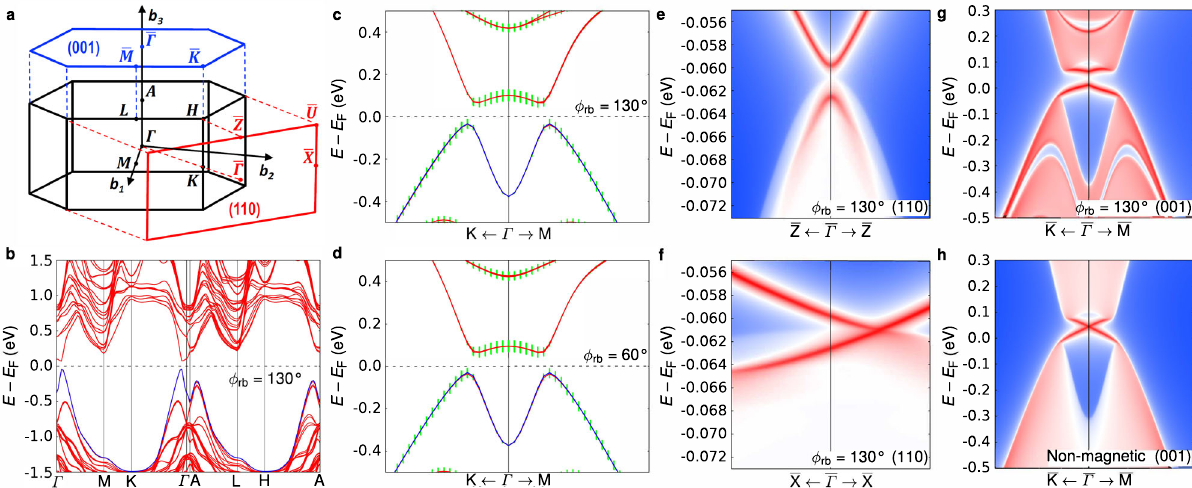
Fig. 3 Bulk and surface electronic-band structures for various magnetic ground states. a Hexagonal Brillouin zone and the projected (110) and (001) surface-Brillouin zones with high-symmetry points (capital letters) and reciprocal-lattice axes ( b 1 = a * , b 2 = b * , and b 3 = c * ) indicated. b Bulk band structure along high-symmetry paths for broken-helix order with ϕ rb = 130 ∘ . E F is the Fermi energy. c , d Views of the minimal gap region along the K- Γ -M direction for ϕ rb = 130 ∘ (broken-helix order) ( c ) and ϕ rb = 60 ∘ (pure 60 ∘ -helix order) ( d ) . The top valence band according to simple band fi lling is indicated in blue and the rest of the bands are colored red. Green vertical bars show As 4 p z orbital character and indicate band inversion near the minimal gap. e – h Surface bands for the (110) ( e , f ) and (001) ( g , h ) projected surfaces along high-symmetry lines for ϕ rb = 130 ∘ ( e – g ). A Dirac cone exists on each surface, but the presence of a gap and whether or not the cone is pinned to a time-reversal-invariant momentum (TRIM) depends on symmetry: a gapless Dirac cone unpinned from a TRIM occurs for the (110) surface preserving the 2 0 symmetry axis. On the other hand, the (001) surface ( g ) has a gapped Dirac cone at (cid:1) Γ due to the absence of a 2 0 axis and any other symmetry that reverses an odd number of space – time coordinates. The surfaces with gapped Dirac cones support half-integer quantum-anomalous-Hall-type conductivity. The non-magnetic calculation for the (001) surface ( h ) has a gapless Dirac cone pinned to (cid:1) Γ . Note that panels e and f are zoomed in around the bottom of the band gap to show the details of the surface Dirac cone. E F is inside the gap and the surface Dirac point is at E F − 0.061 eV, very close to the top of the valence band projection. More details of the surface band structure are found in Supplementary Fig. 15g.